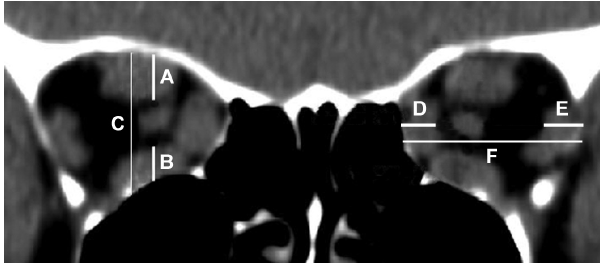
Figure 1 - Schematic representation of the method for calculating Barrett’s Index. The vertical index is calculated by the sum of the vertical muscle diameters (A and B) divided by the vertical dimension of the orbit (C). The horizontal index is calculated by dividing the sum of the horizontal muscle diameters (D and E) by the horizontal diameter of the orbit